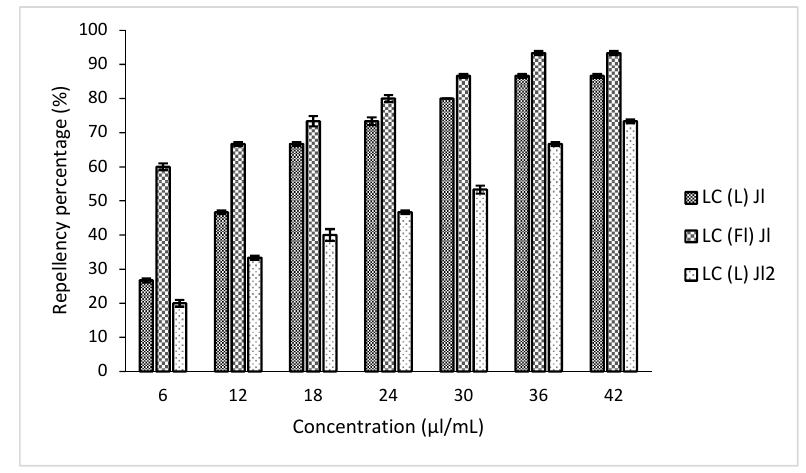
Figure 5. Repellency percentage of L. camara essential oils.